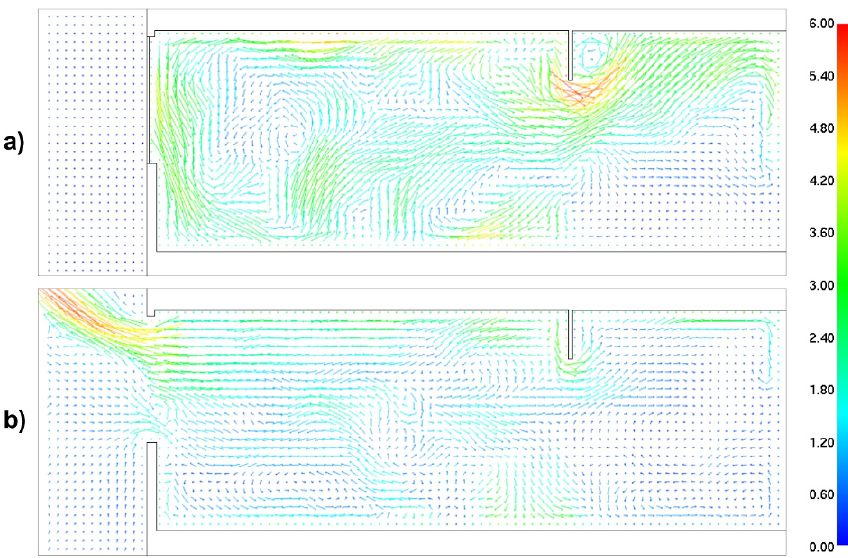
Figure 11. Velocity vectors fields on section 3.3 X – a) 300 and b) 1140